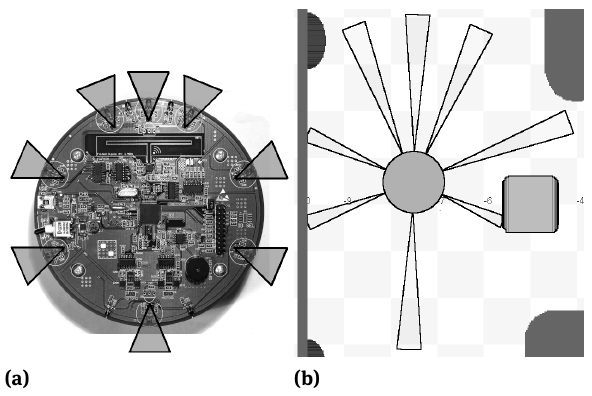
Figure 6: Top view: (a) – robot, (b) – simulation prototype.